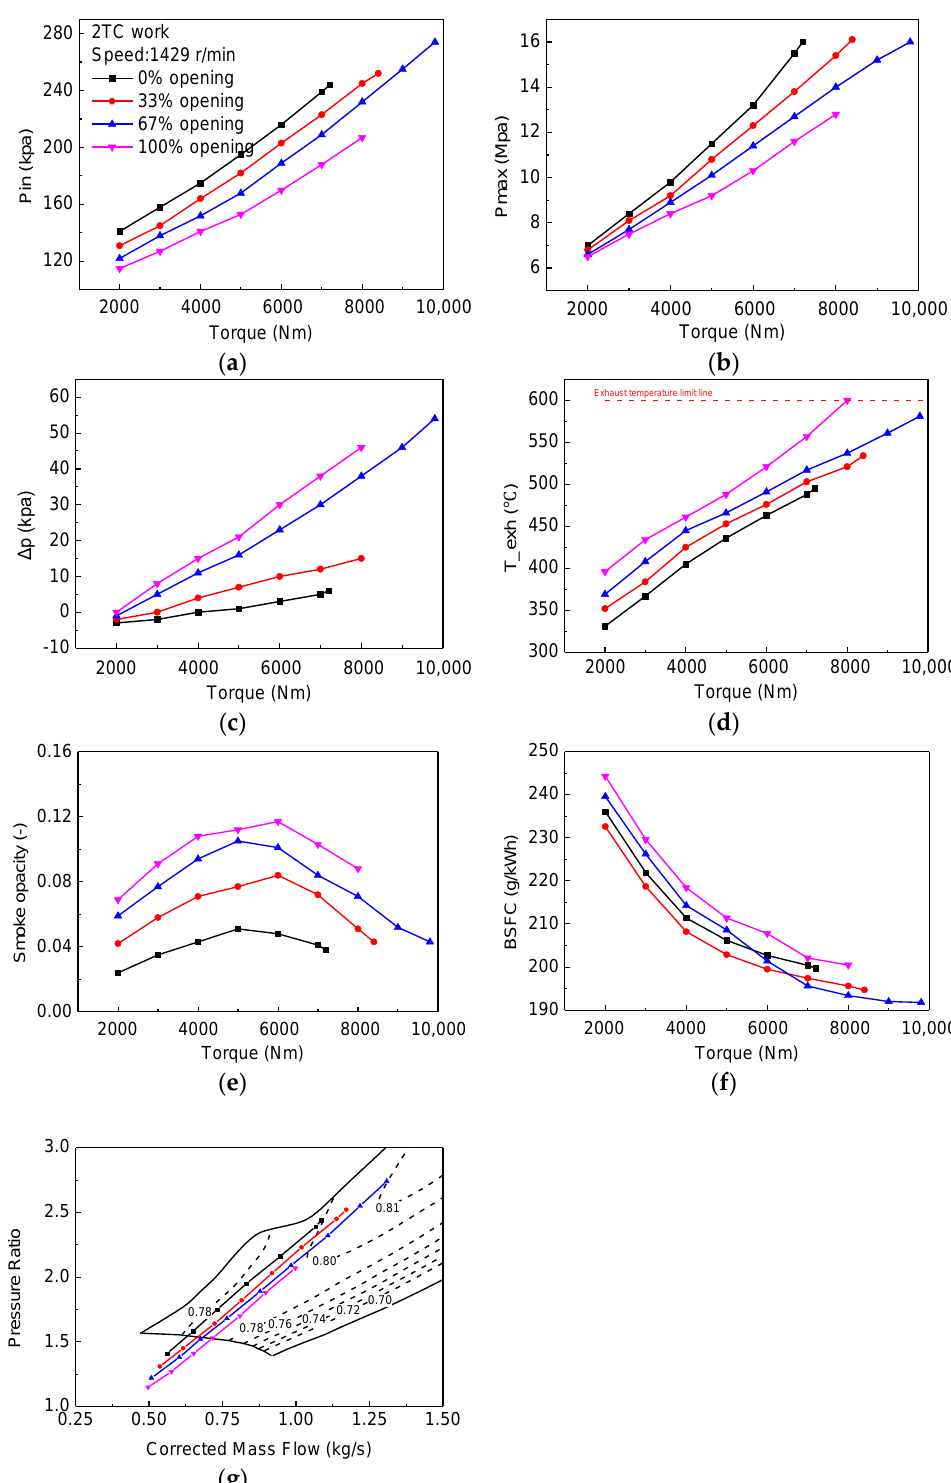
Figure 2. Variations of the main engine parameters at 1000 r/min with the 2TC. ( a ) intake pressure. ( b ) the maximum combustion pressure. ( c ) difference between the intake and exhaust pressures. ( d ) ex- haust temperature. ( e ) smoke opacity. ( f ) the brake specific fuel consumption. ( g ) compressor map.